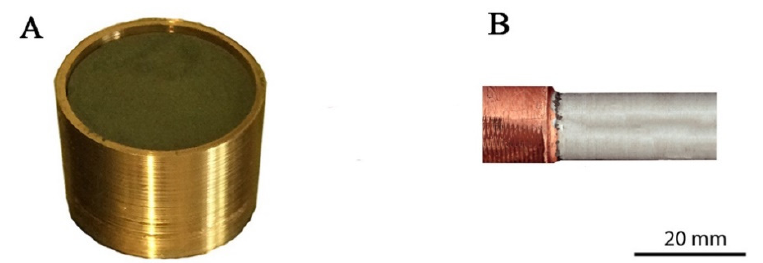
Figure 1. The container with the Zr-Cu mixture before and after the extrusion process: ( A ) container made of Cu-ETP with the Zr-2.5Cu mixture; ( B ) product after the extrusion.